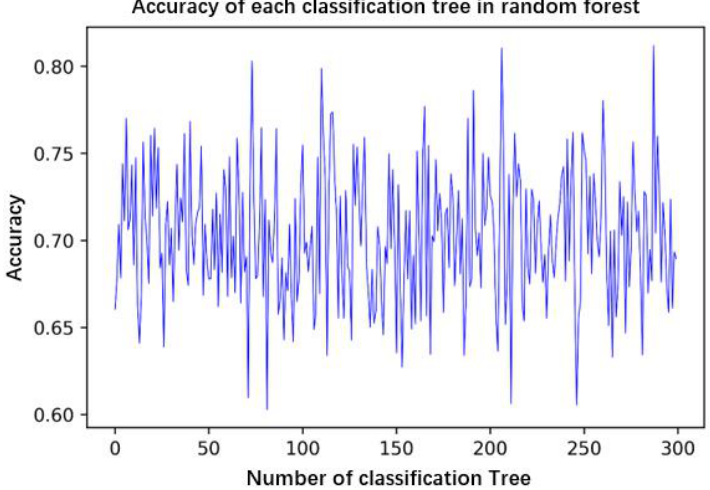
Figure 8. Accuracy of each base classifier.